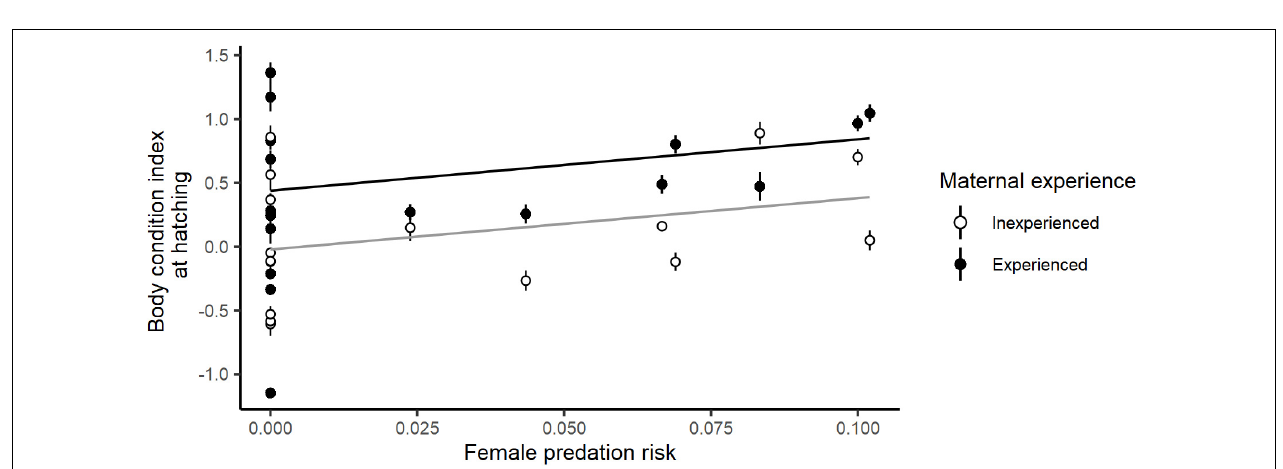
FIGURE 4 | Relationship between the body condition index at hatching of female eiders and island-specific female predation risk for experienced (in black) and inexperienced (in gray) breeders. Dots correspond to island-specific mean body condition indices at hatching for experienced (in black) and inexperienced (in white) breeders, respectively, and bars account for the standard